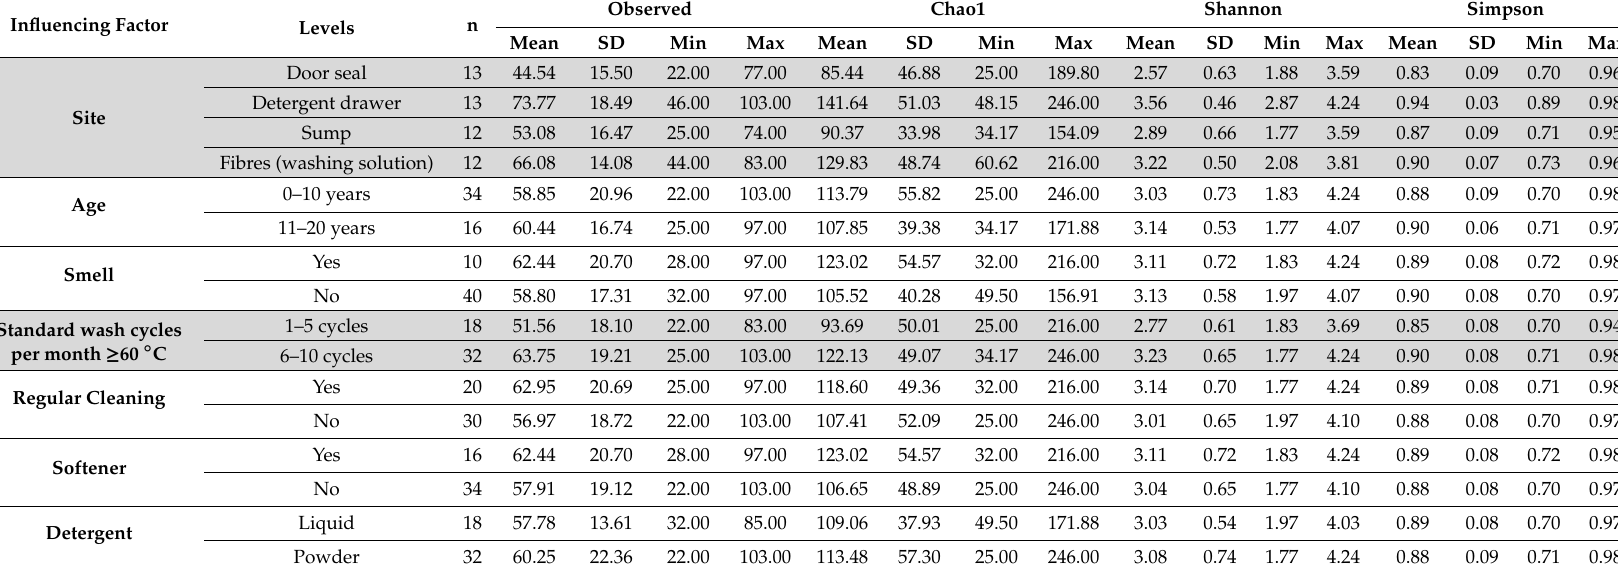
Table 1. Summary of the distribution of alpha diversity indices for the investigated factors potentially influencing the bacterial community of washing machines. Factors that had a significant influence are highlighted in grey. Displayed are mean values, minimum and maximum value as well as standard deviation of each diversity